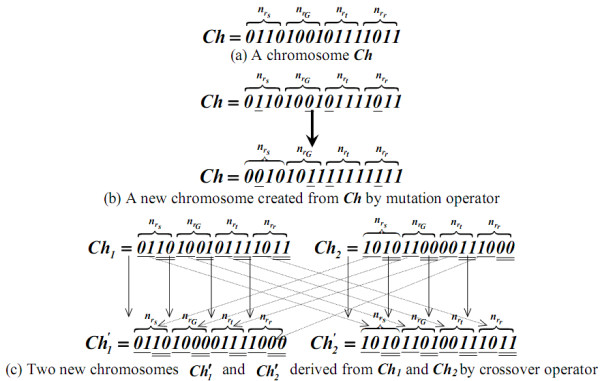
An example for GBPD.